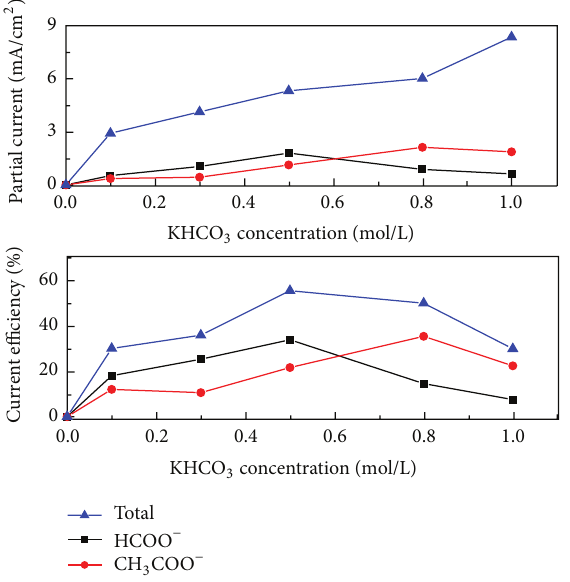
Figure 6: Variation of formic acid and acetic acid via KHCO 3 concentration (4V,